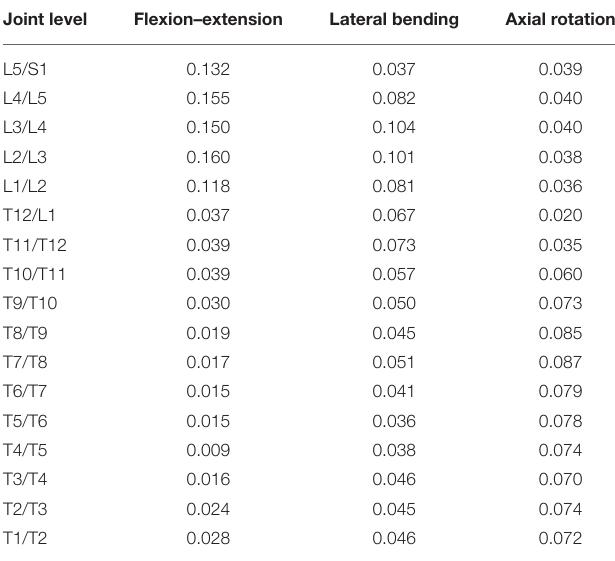
TABLE 2 | Ratios of individual-level intervertebral motions to overall spine motion were used to create kinematic constraints in flexion–extension, lateral bending, and axial rotation tasks.